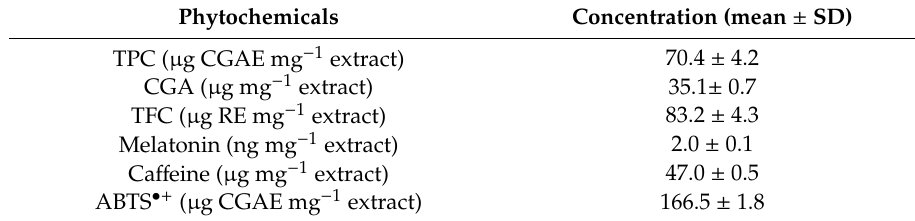
Table 1. Phytochemical characterisation of the co ff ee silverskin extract (CSE), including total phenolic antioxidant capacity measured by the ABTS • +